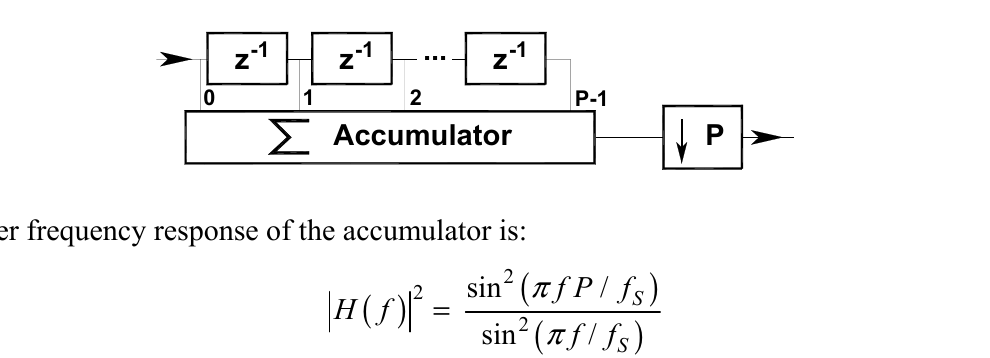
Figure 11. The accumulator modeled as an adaptive P-order moving average low-pass filter, followed by a